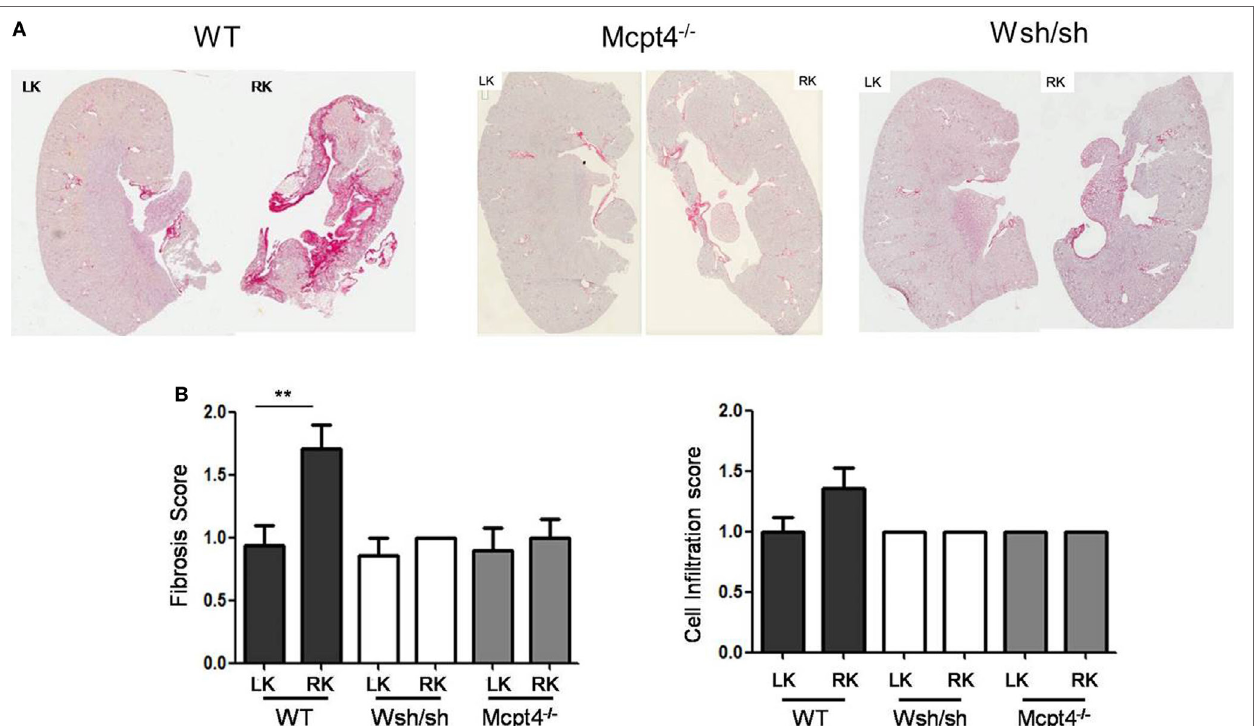
FigUre 4 | evaluation of fibrosis and cellular infiltration after partial unilateral ureteral obstruction . (a) Representative images of Sirius Red-stained sections from operated right kidneys (RKs) and left kidneys (LKs) of WT, MC-deficient, and MCPT4-deficient mice at D75 post-surgery. (B) Quantitative analysis of fibrosis (left panel) and inflammatory cells infiltration (right panel) of LK and RK at D75 post-surgery. Data are the mean ± SEM of indicated numbers of mice [see panel (a) ], ** p ≤